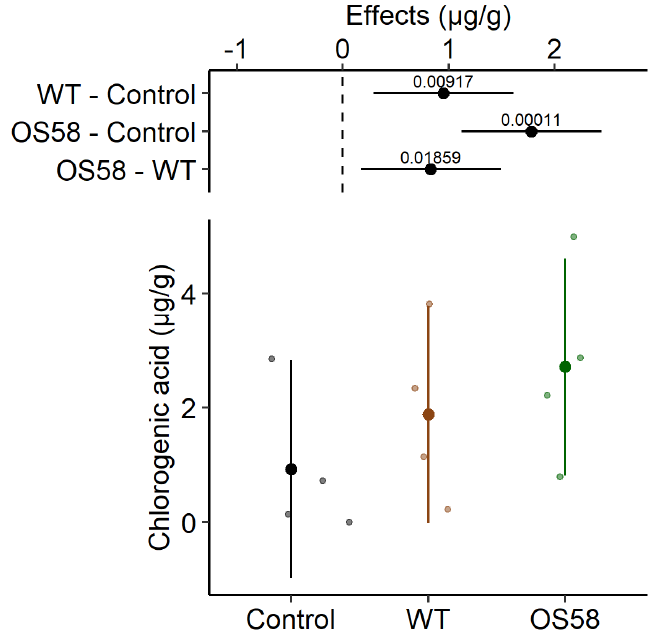
Figure 4. The chlorogenic acid content (calculated as μ g per gram of fresh cauliflowers) is reported for the Control, WT, and OS58 groups. A detailed description of these types of plots is provided in Figure 2. Figure